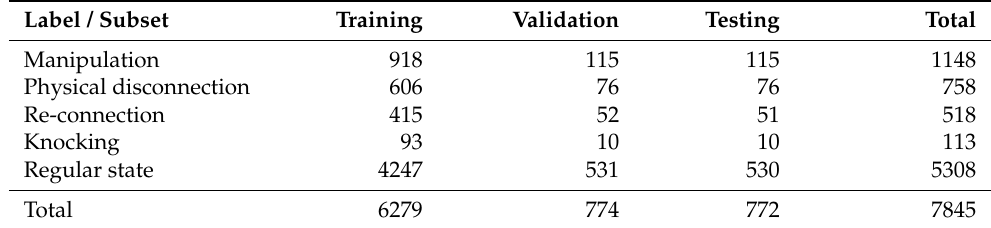
Table 1. The number of dataset samples per subset and